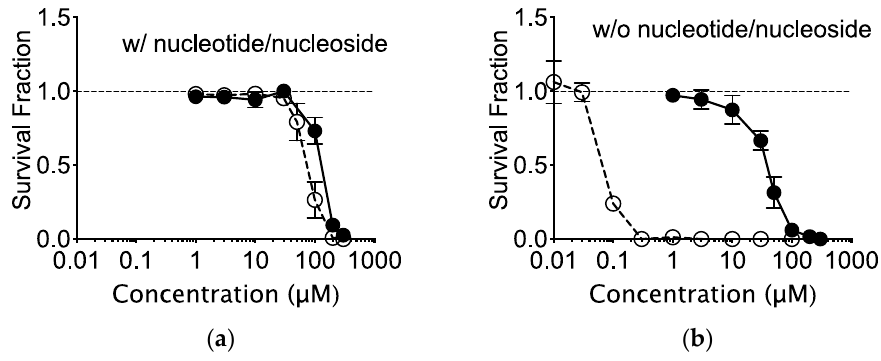
Figure 1. Cytotoxicity of bromodeoxyuridine (BrdU) and ethynyldeoxyuridine (EdU) to Chinese hamster ovary (CHO) cells. CHO cell survival against BrdU or EdU in the presence ( a ); or absence ( b ) of nucleotide / nucleoside supplement. Open circles indicate EdU and closed circles indicate BrdU. Error bars represent the standard error of the mean of three independent experiments.